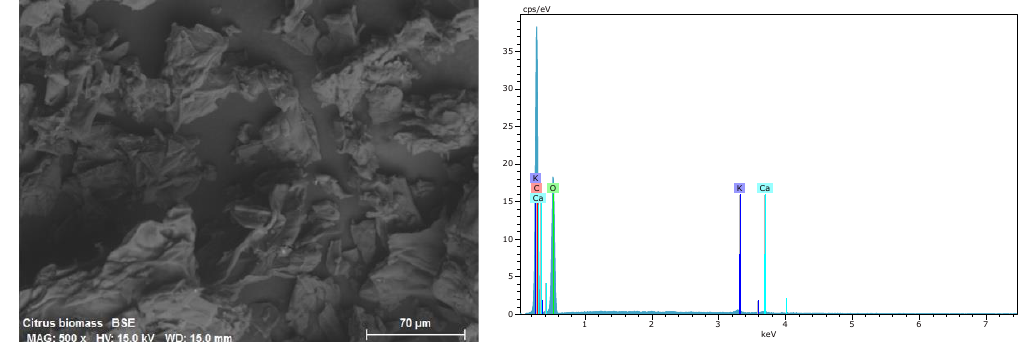
Figure 2. SEM image and EDS analysis of citrus-waste biomass.